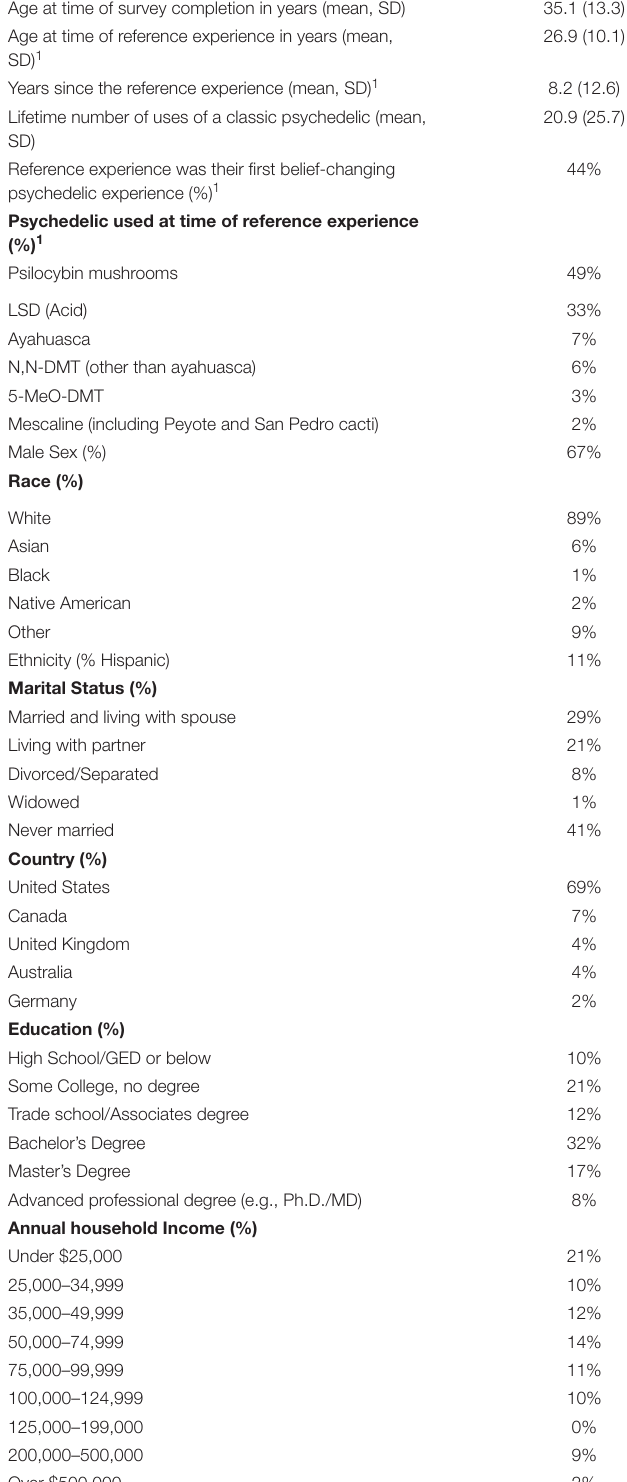
TABLE 1 | Participant characteristics ( N =